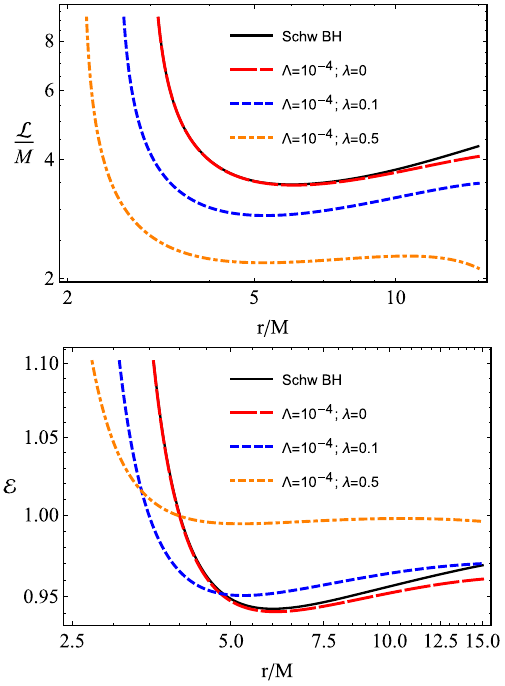
Fig. 2 The radial dependence of the specific angular momentum (top panel) and energy (bottom panel) for test particles orbiting around Schwarzschild–de Sitter BH surrounded by PFDM for different val- ues of the DM parameter in the case of positive cosmological constant. In this plot we use Λ → Λ/ M 2 and λ → λ/